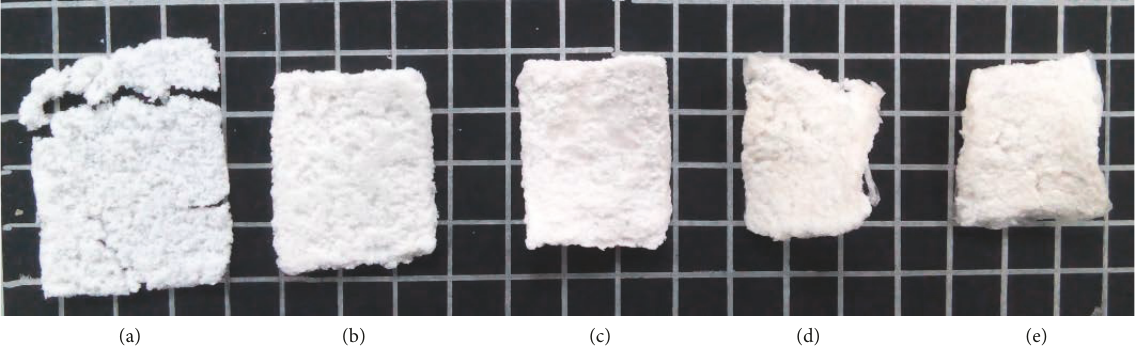
Figure 6: Aerial view of the infused carrageenan porous 3D scaffold 2 days after immersion: (a) 2% (w/v) carrageenan; (b) 4% (w/v) carrageenan; (c) 6% (w/v) carrageenan; (d) 8% (w/v) carrageenan; and (e) 10% (w/v) carrageenan.